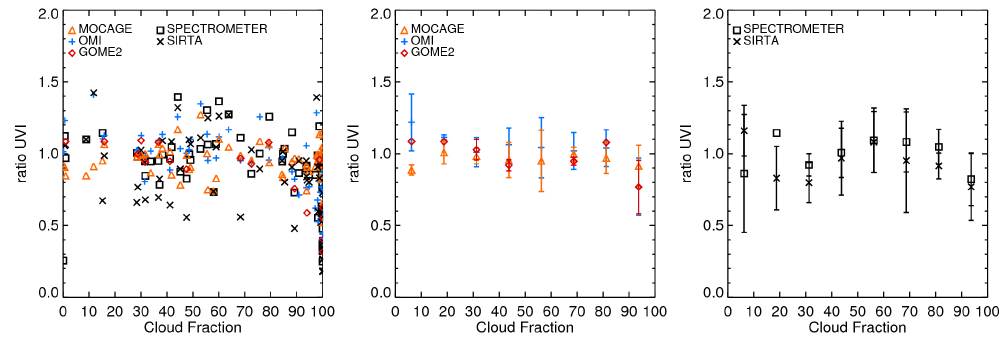
Fig. 10. Evolution of the ratio of the UVI observed and modelled to the UVI modelled on clear-sky conditions with the TUV model, as a function of the cloud coverage. Comparisons between satellite UVI products (OMI, GOME2), MOCAGE model, spectrometer and the average of SIRTA instruments (pyranometer UVAE, pyranometer UVB, biometer) during RISC-UV campaigns for individual data (left) and data binned in octal intervals (middle and right). The error bars shown in the middle and right panels represent ± one standard deviation of the binned